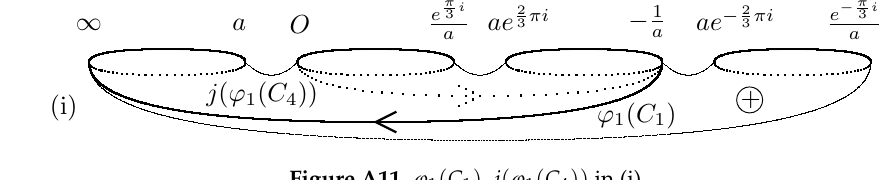
Figure A11. ϕ 1 ( C 1 ) , j ( ϕ 1 ( C 4 )) in (i).